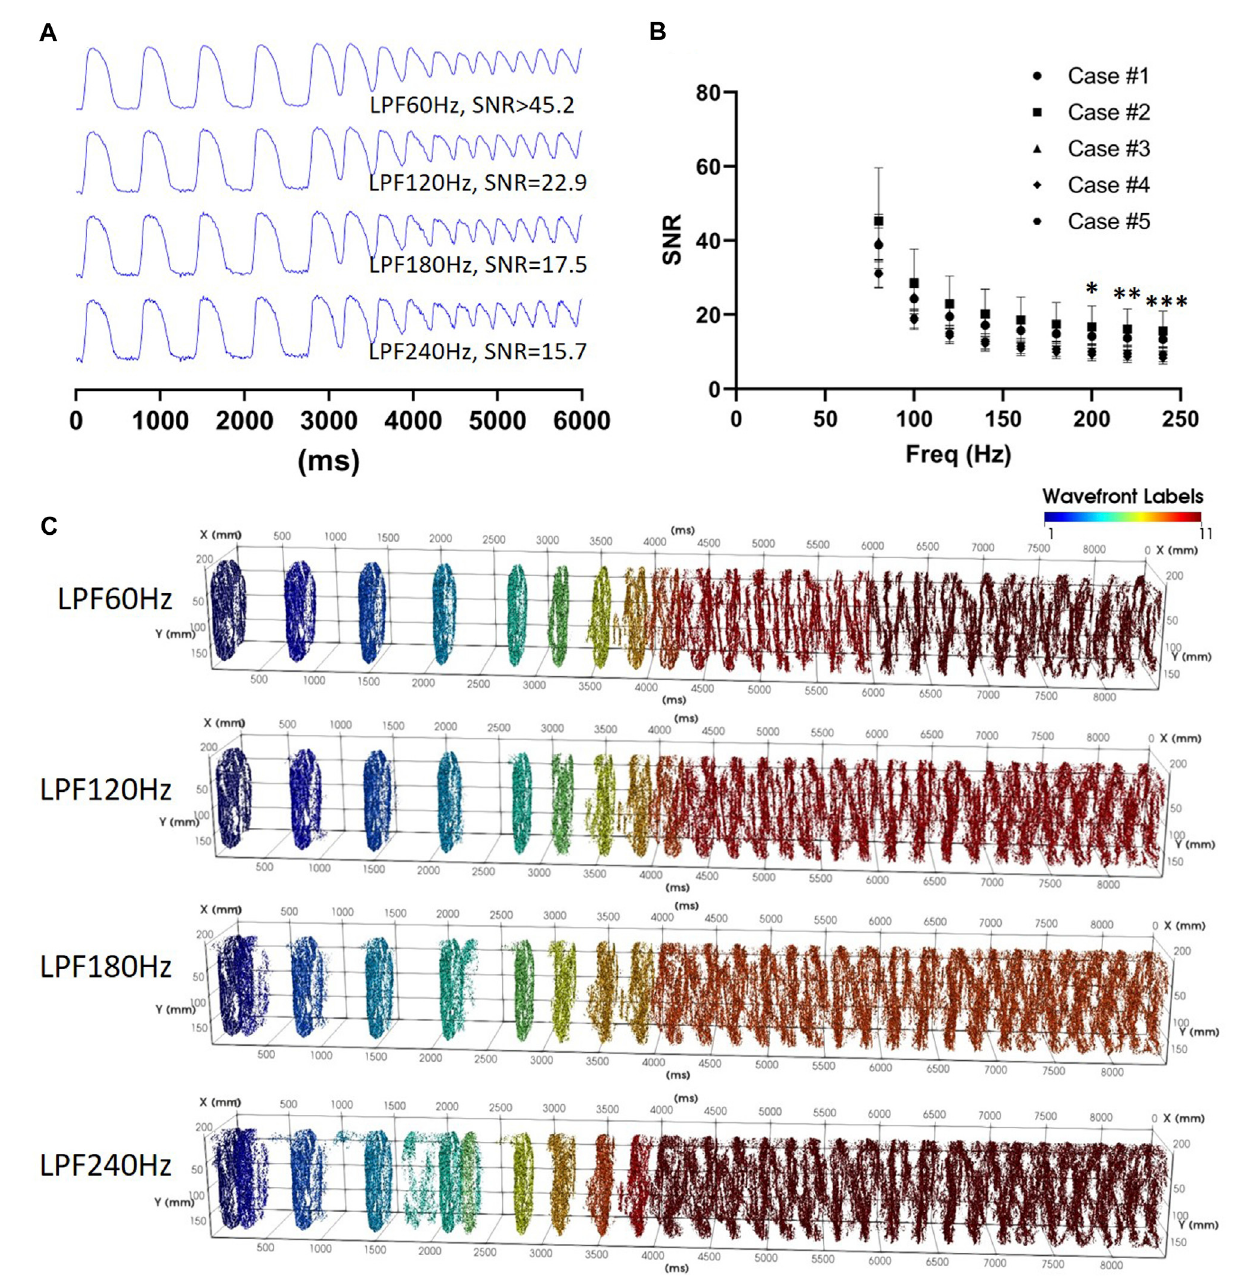
FIGURE 9 In fl uencesofthesignal-to-noiseratio. (A) Actionpotentialtraceswithvaryinglowpass fi ltercut-offfrequencies. (B) Mean±standarddeviationsignal-to- noiseratiosforexperimentalopticalmappingrecordingsduringS1S2S3S4stimulationandtachyarrhythmiainduction(N=5). (C) Spatio-temporal distribution of pAT points corresponding to recordings used in